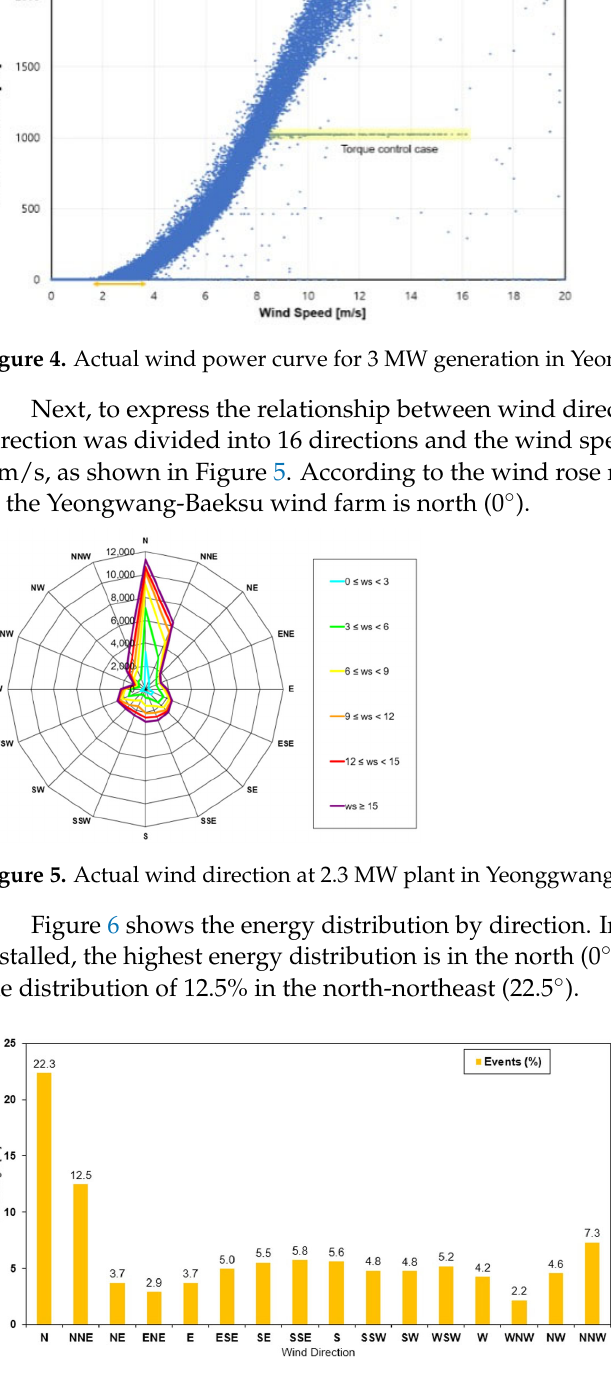
Figure 7. Distribution of wind speed classes. To enhance the forecasting accuracy for power generation, we analysed the correlation between power generation and the added exogenous variables of wind direction, wind speed, temperature, atmospheric pressure, and humidity, the results of which are shown in Figure 8. For all variables except wind speed, a strong correlation coefficient of at least 0.8 or correlation of at least 0.6 with power generation was not detected; hence, model selection was performed with all variables included in the analysis [49]. However, multicollinearity may occur when atmospheric pressure and temperature are considered simultaneously; hence, these two variables were separately input to the models and the results were compared to select the optimal variable.